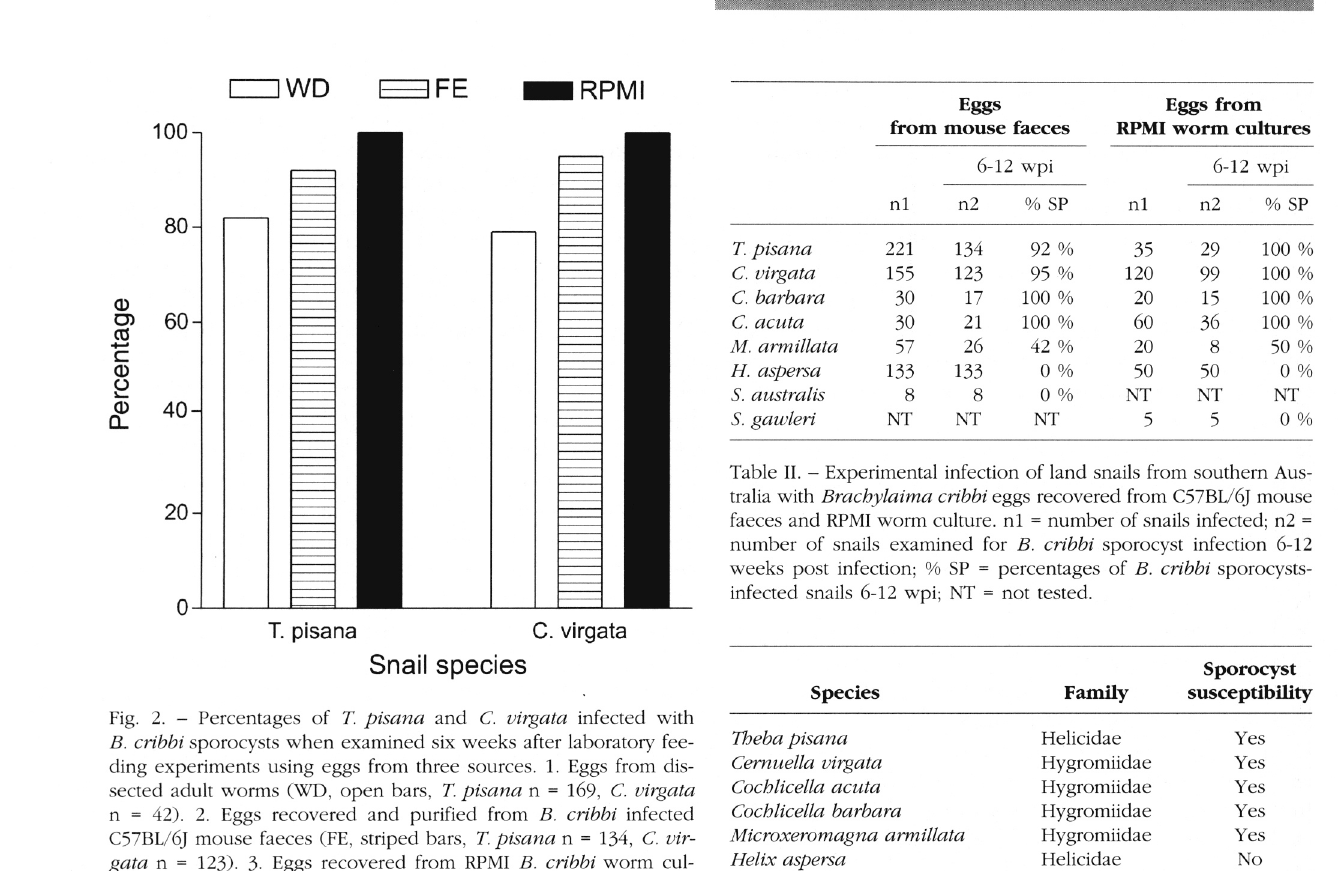
Table III. - Summary of susceptibility of eight land snail species from southern Australia as first intermediate host to B. cribbi using field and experimental